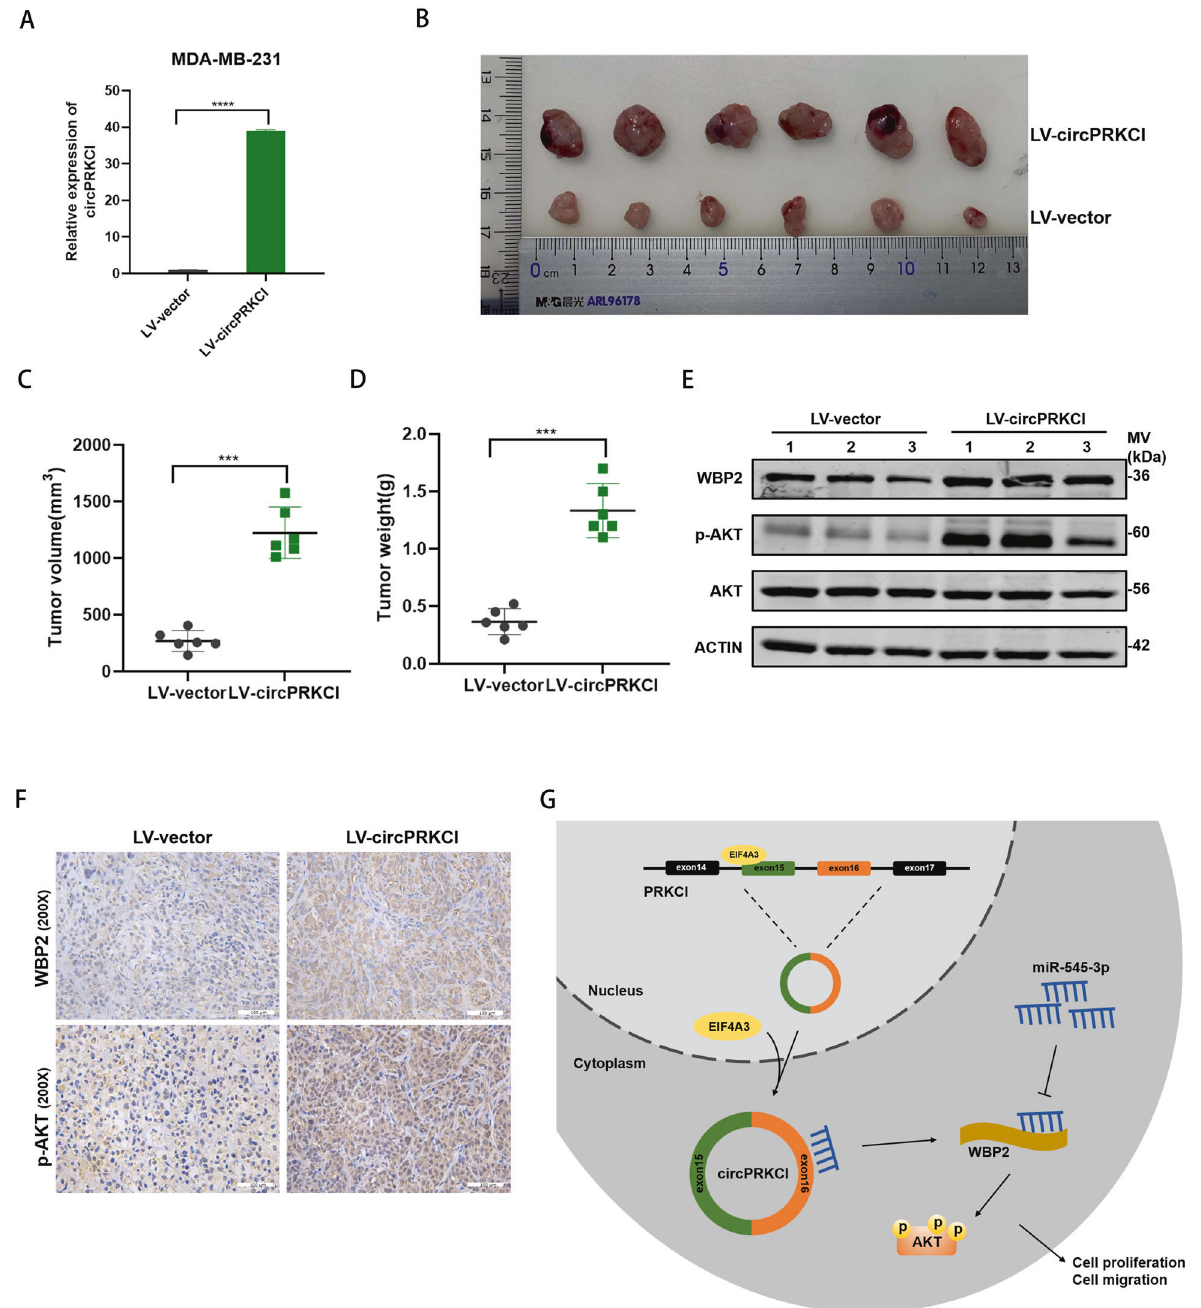
Fig. 8 Overexpression of circPRKCI promoted BC tumor growth in vivo. A Overexpression of circPRKCI was con fi rmed by qRT-PCR in MDA- MB-231. B Representative images of xenograft tumors in nude mice (6 mice per group). C Average tumor volume of nude mice. D Average tumor weight of nude mice. E Extract protein from tumors and measuring the expression of WBP2, AKT and p-AKT by Western blotting. F Immunohistochemistry (IHC) staining of WBP2 and p-AKT in xenografts. G The mechanism diagram was generated to illustrate the mechanism of EIF4A3-circPRKCI-miR-545-3p-WBP2 axis in TNBC. *** p < 0.001,**** p <